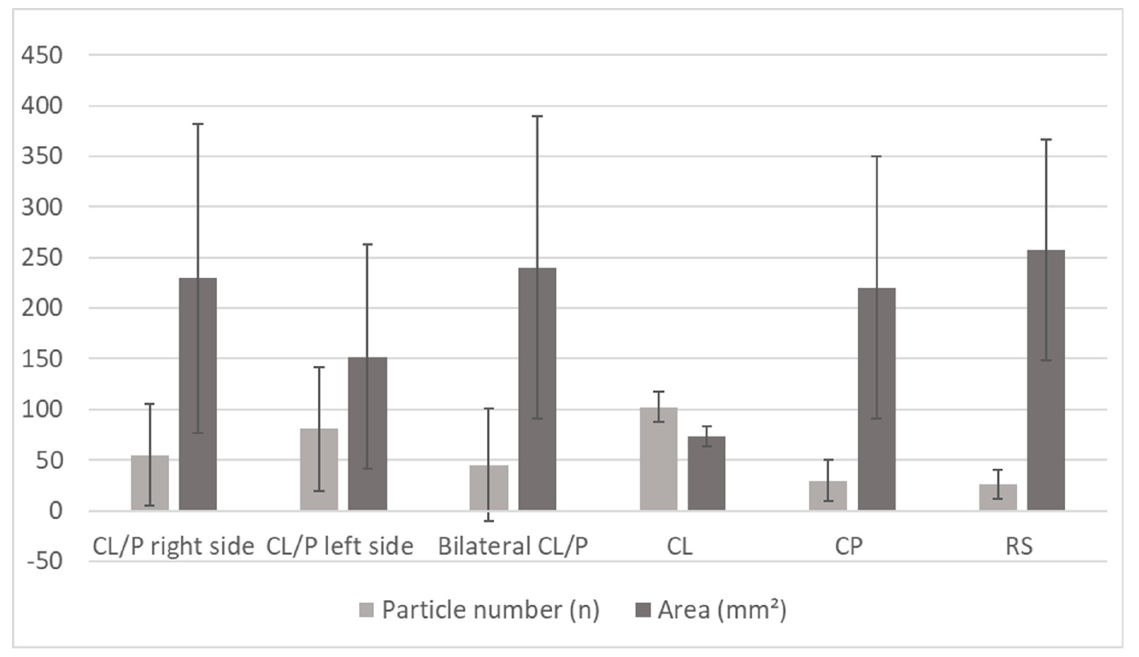
Figure 2. Results of the nine chewing cycles for the different CD cleft formations: right-sided (n = 8), left-sided (n = 18) and bilateral cleft lip and/or palate (n = 6), cleft lip (n = 2), cleft palate (n = 4) and Robin sequence (n = 4). Mean and standard deviation for number of particles (n) and area (mm 2 ) are shown. Abbreviations: CL/P = Cleft lip and/or palate; CL = Cleft lip; CP = Cleft palate; RS = Robin sequence.